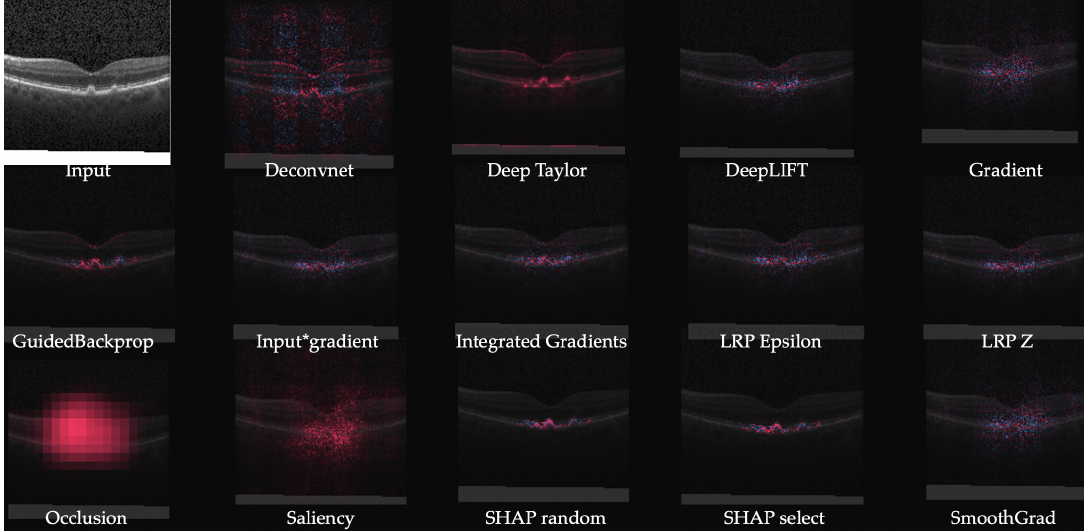
Figure 4. Example of heat maps from a retinal OCT image